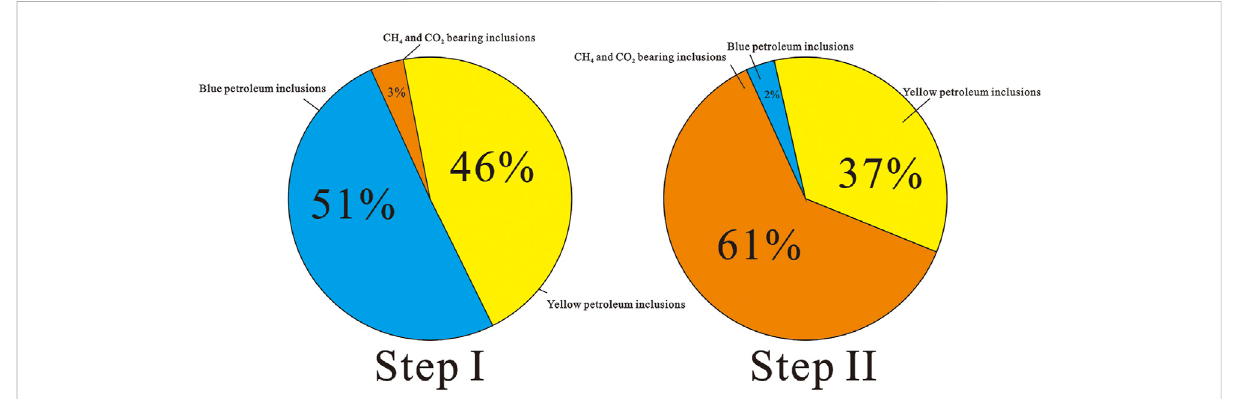
FIGURE 7 Statistics of the abundance of different types of inclusions in different structural